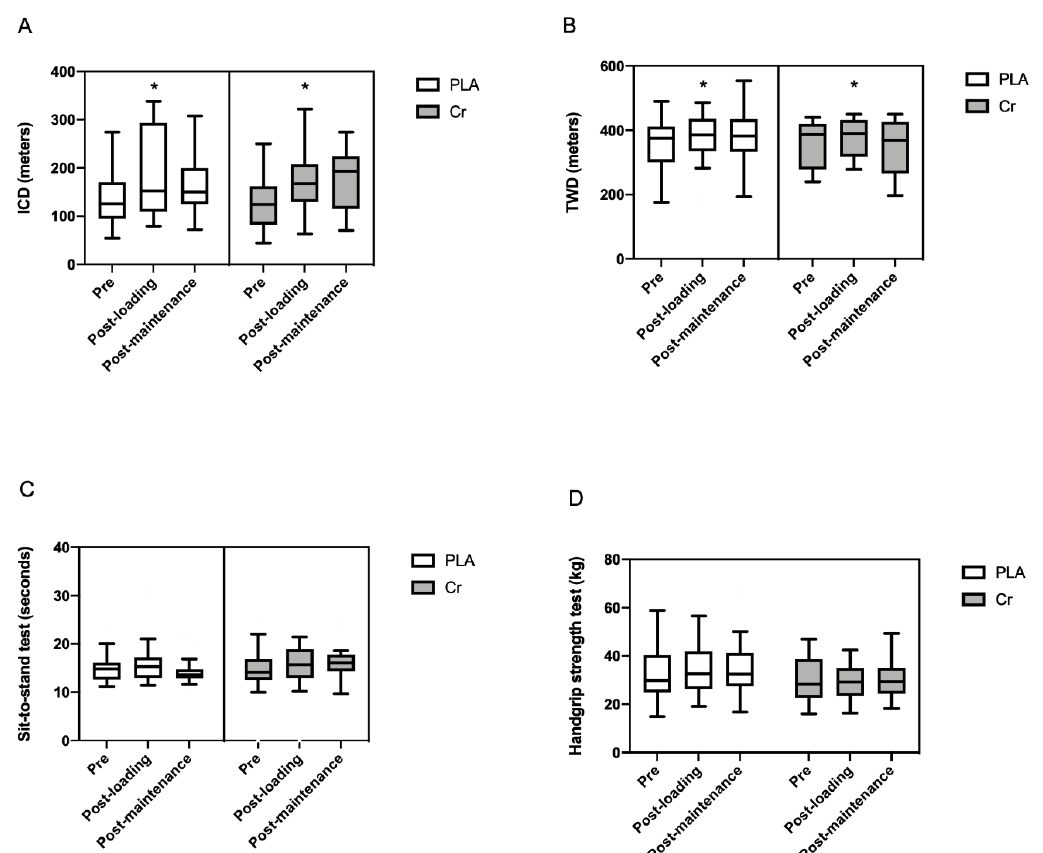
Figure 3. Functional capacity parameters obtained during the 6MWT test, handgrip strength test, and sit-to-stand test before (pre) and after the loading and maintenance supplementation period in symptomatic peripheral arterial disease ( n = 29; PLA = 15 and Cr = 14). Data are expressed as the median and interquartile range. * Significant difference pre vs. post loading supplementation period ( p < 0.05). ( A ) ICD = initial claudication distance; ( B ) TWD = total walking distance; ( C ) sit-to-stand test; ( D ) handgrip strength test. PLA—placebo group; Cr—creatine group.